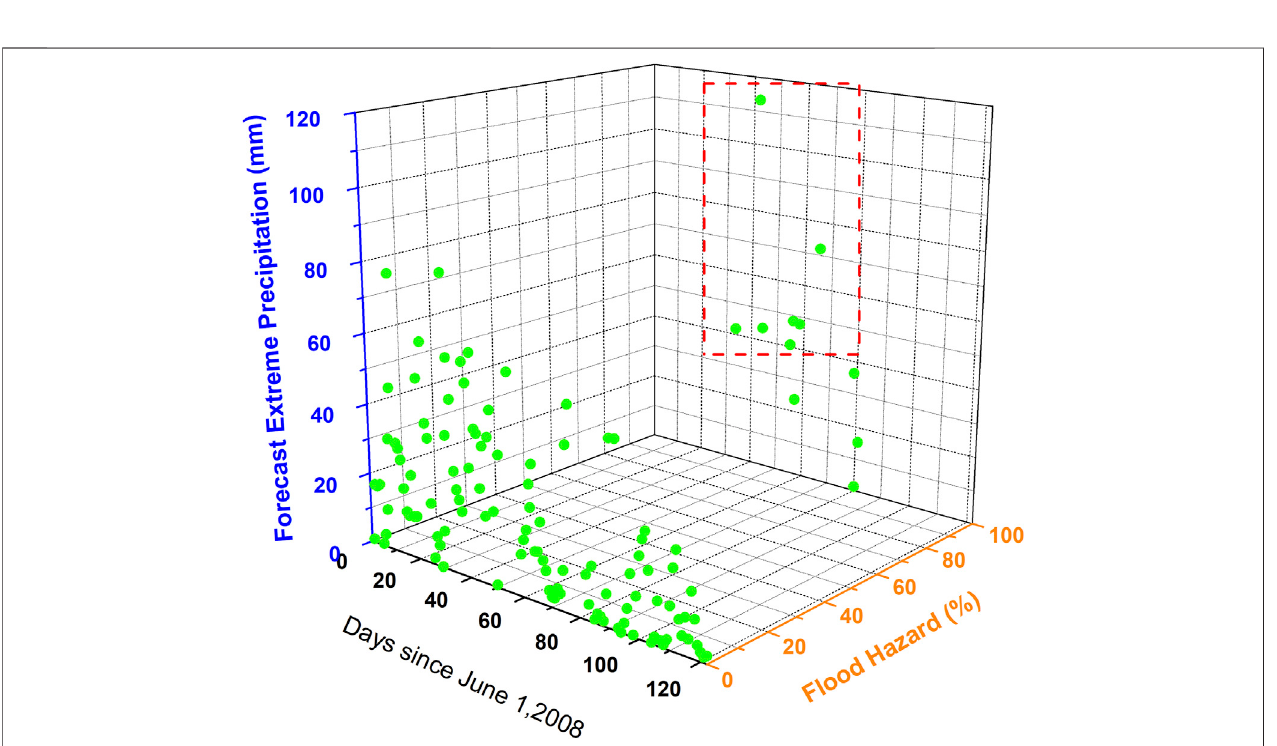
FIGURE 7 | Combination of the fl ood hazard and extreme precipitation information (the points in the red rectangle indicate the days with high precipitation amount and fl ood hazard).